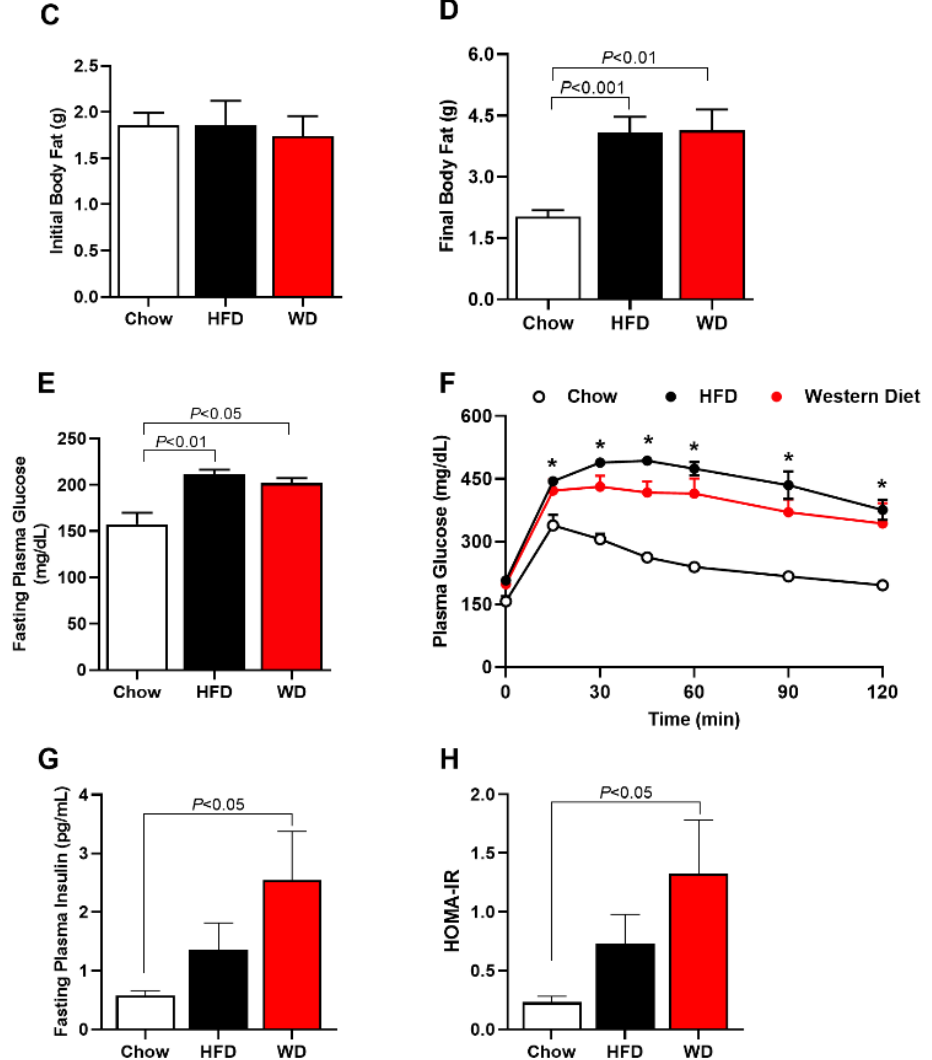
Figure 1. ApoE KO Mice fed an HFD or WD displayed increased body weight, body fat, fasting plasma glucose, plasma insulin and glucose intolerance. Initial body weight (before diet) ( A ); final body weight (after 7 weeks of HFD or WD) ( B ). Initial body fat (before diet) ( C ); final body fat (after 7 weeks of HFD or WD) ( D ); fasting plasma glucose ( E ). Area under curve (AUC) of plasma glucose at different times ( F ). Fasting plasma insulin ( G ). Homeostasis model assessment of insulin resistance (HOMA-IR) ( H ). Data are represented as mean ± SEM (N = 5–9). The statistical differences as indicated by one-way ANOVA were as follows: * p < 0.05 represents the difference between Chow (regular diet) vs. HFD; Chow (regular diet) vs. WD.